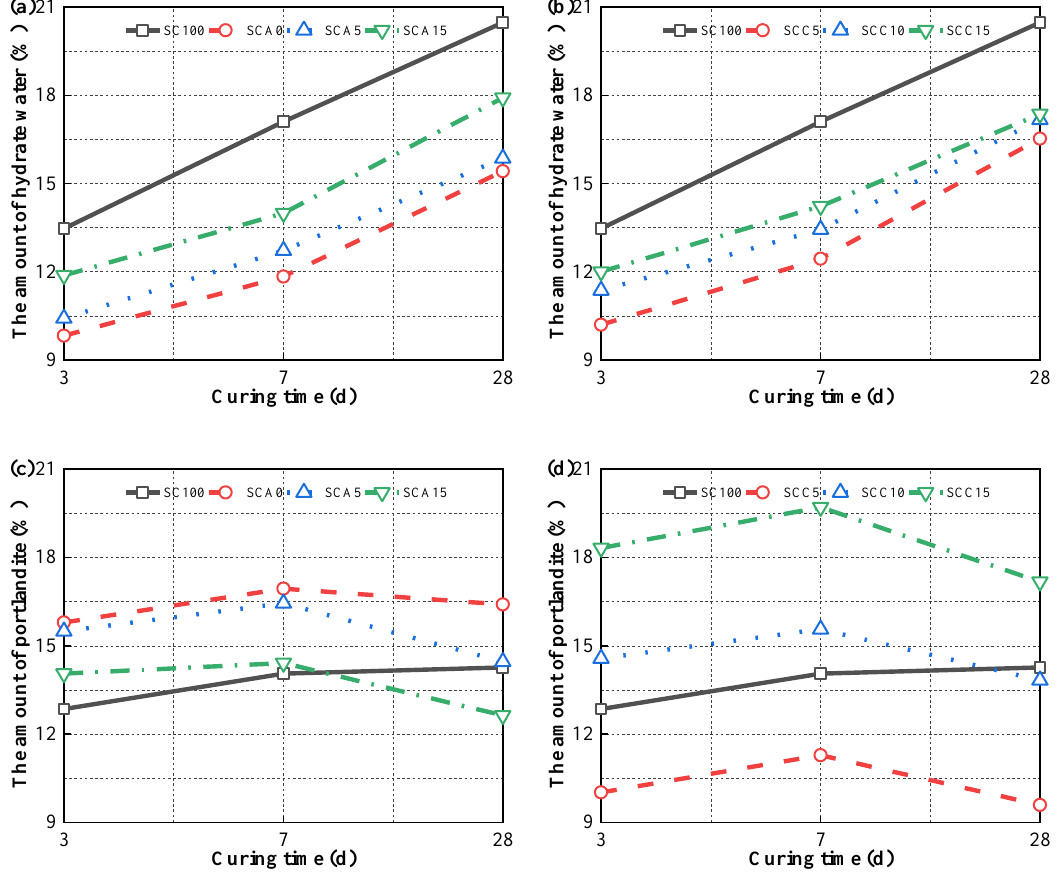
Figure 12. The content of hydrate water of binder pastes with different doses of ( a ) C Ṡ A and ( b ) quicklime, and the content of portlandite of binder pastes with different doses of ( c ) C Ṡ A and ( d ) quicklime.